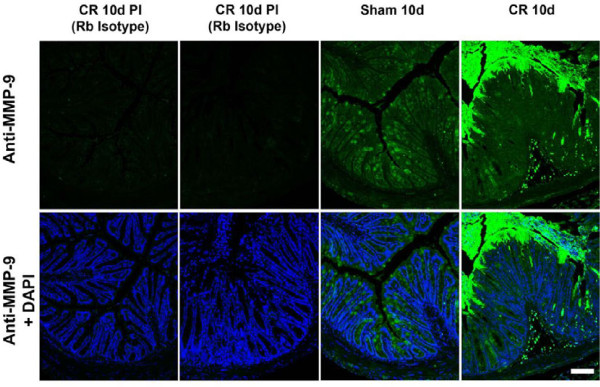
MMP-9 expression is increased withC.
rodentiuminfection. Immunohistochemistry shows that
MMP-9 distributed throughout the crypts (green) in uninfected WT mice is
localized primarily to the apical surface of intestinal epithelium in
C. rodentium-infected (10d) WT mice. Scale bar,
100 μm.